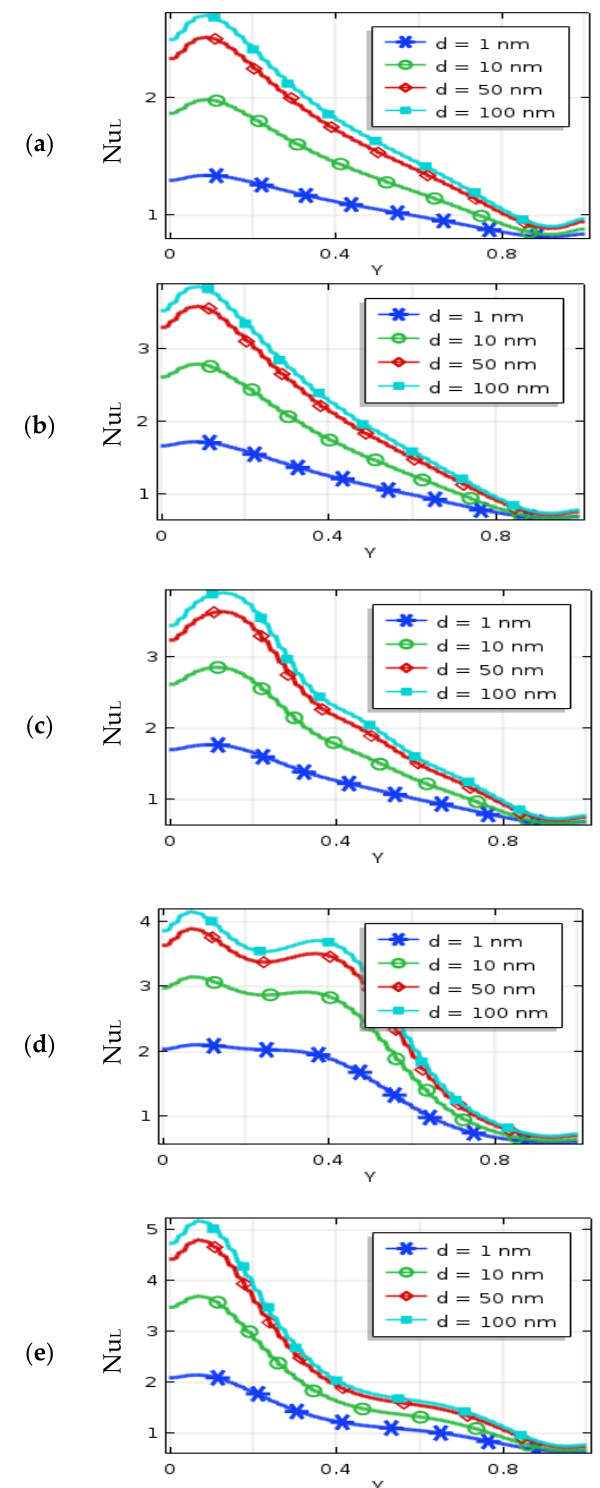
Figure 10. Local Nusselt Number for nanoparticles diameter ( d ) and ( a ) umf, ( b ) λ = 0.1, ( c ) λ = 0.25, ( d ) λ = 0.5, and ( e ) λ = 1 when Ra = 10 6 , Ha = 30, n = 3, ϕ = 0.04, and τ = 1.